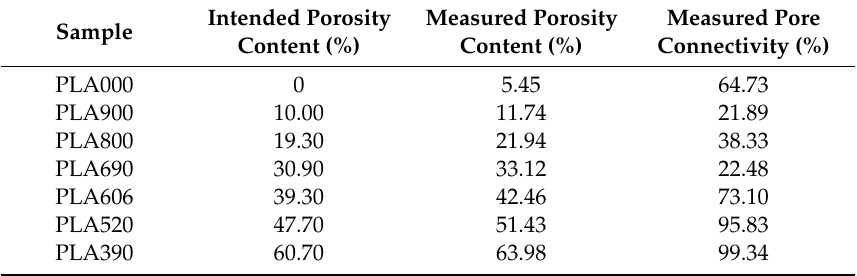
Table 2. Summary of main structural parameters associated with 3D printed cellular